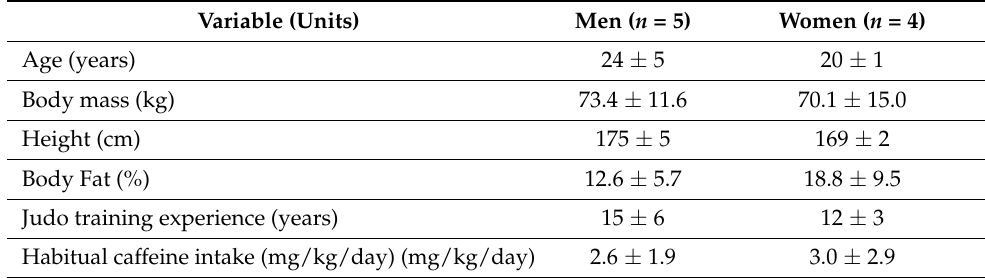
Table 1. Main participants’